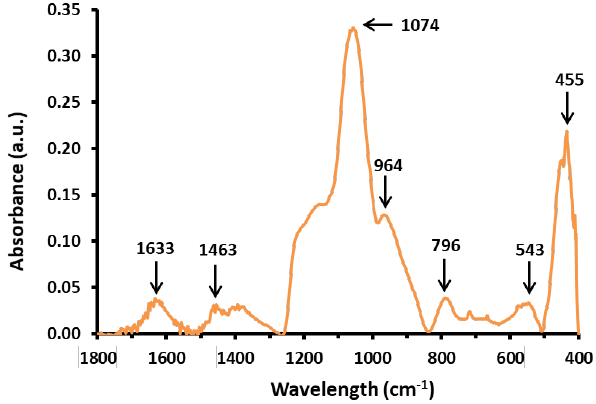
Figure 5. FTIR absorbance spectrum for sample INT-SiO 2 -1P.